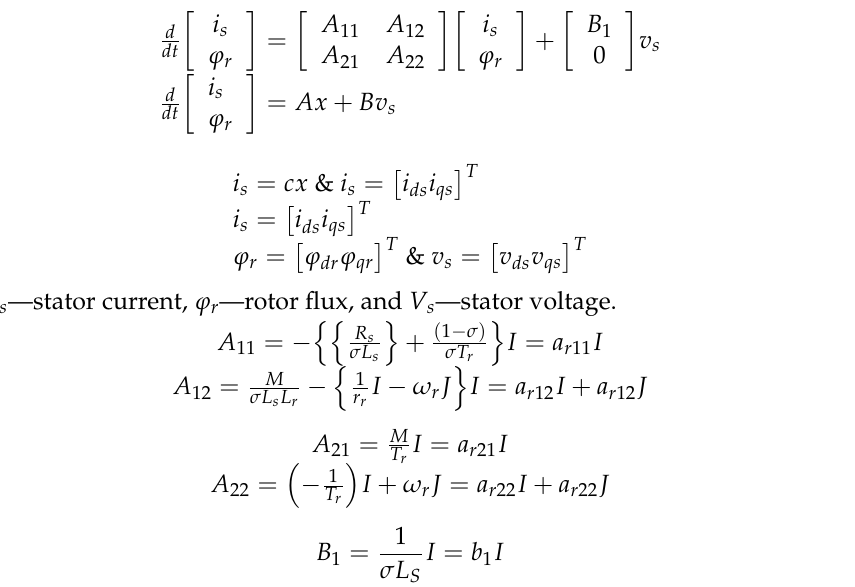
Figure 14. Open loop observer.